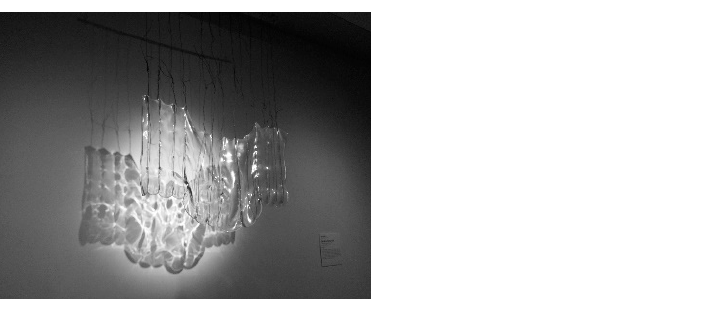
Figure 11. A view showing architectural lighting emphasizing an exhibit at Toledo Museum of Art.